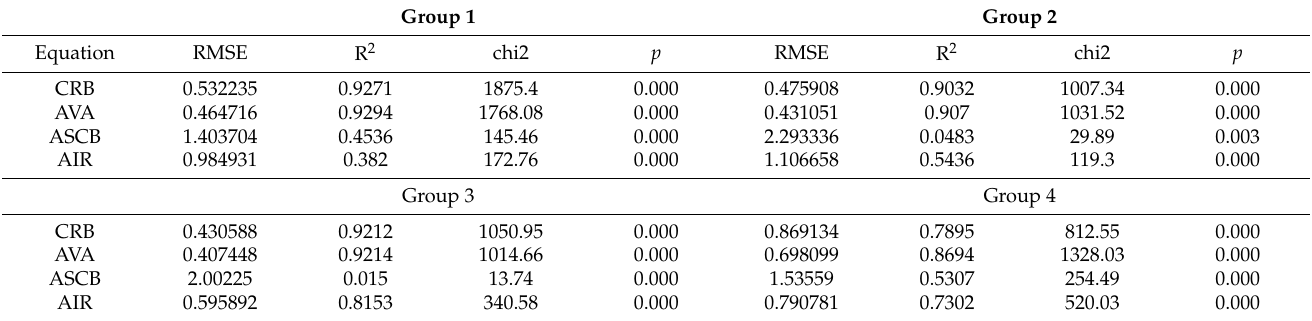
Table 4. Model summary and